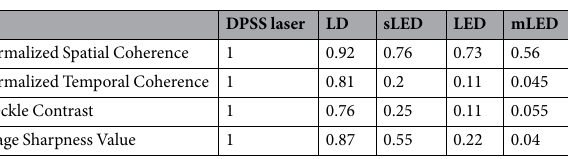
Table 1. Normalized spatial and temporal coherence and speckle contrast and image